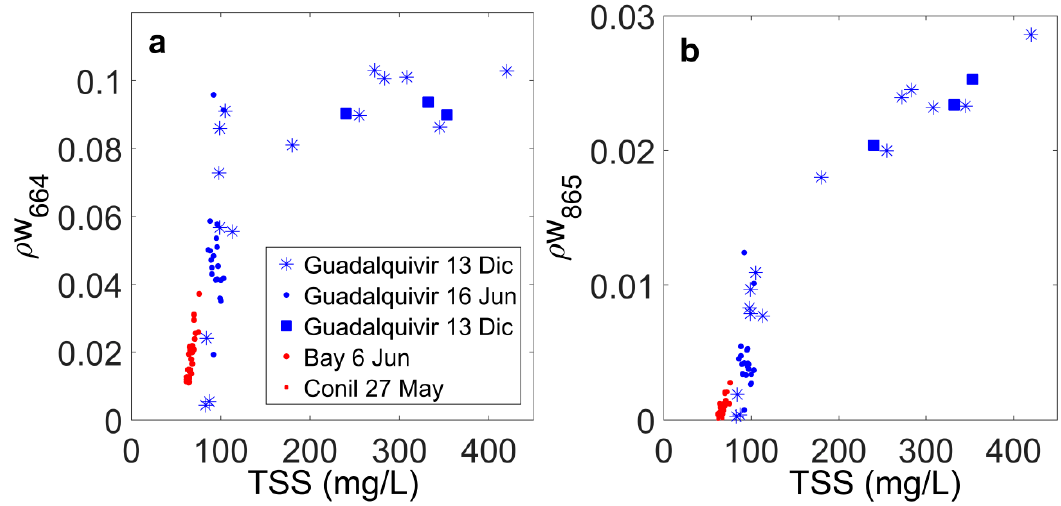
Figure 3. ( a ) Scatter plot showing the comparison between in-situ Total Suspended Solids (TSS) concentration (mg/L) and water reflectance ( ρ w) of Sentinel-2A during the four field campaigns conducted during 2016 in the Guadalquivir estuary (blue) and Cádiz Bay and Conil port (red) for the red band (664 nm), ( b ) the same for near-infrared (NIR, 865 nm) band.